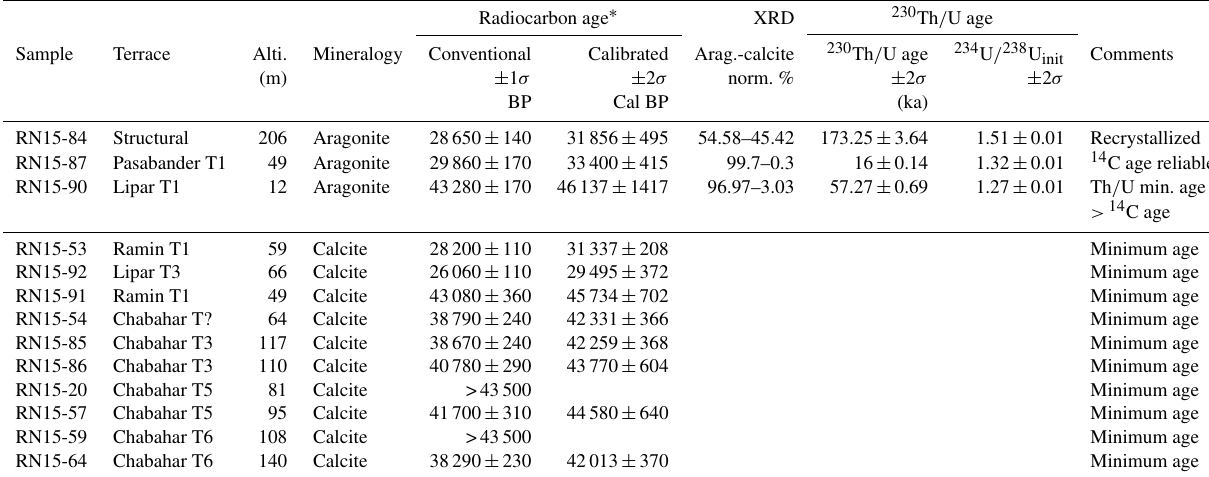
Table 1. Results of radiometric